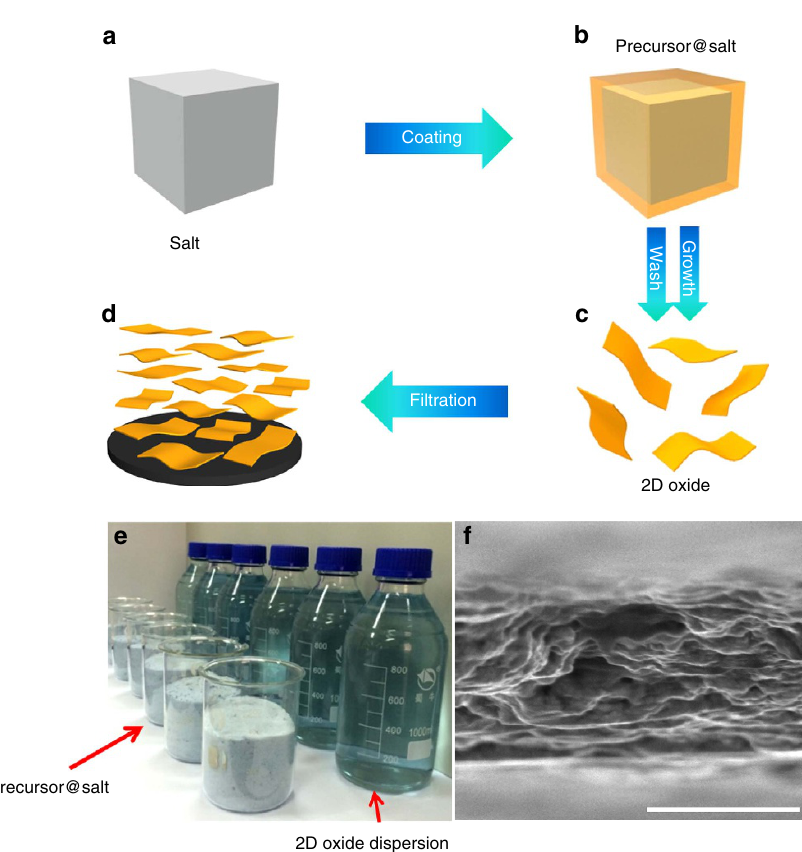
Figure 1 | Schematic representation of 2D h -MoO 3 synthesis and electrode fabrication for energy storage. ( a , b ) Schematic representation of the fabrication process. The precursor solution was coated on the salt by mixing the solution with a large amount of salt microcrystals. ( c ) After thermal annealing and rinsing in water, 2D oxide flakes were obtained. ( d ) Pseudocapacitor electrodes were fabricated by filtering the 2D oxide/ethanol dispersion using a Celgard separator. ( e ) Optical image of the precursors and 2D h -MoO 3 -ethonal dispersions. The front row shows six beakers containing the precursor, and the back row shows six bottles containing the 2D h -MoO 3 -ethanol dispersions. ( f ) Multilayered 2D oxide is shown in the cross-sectional SEM image. Scale bar, 1 m